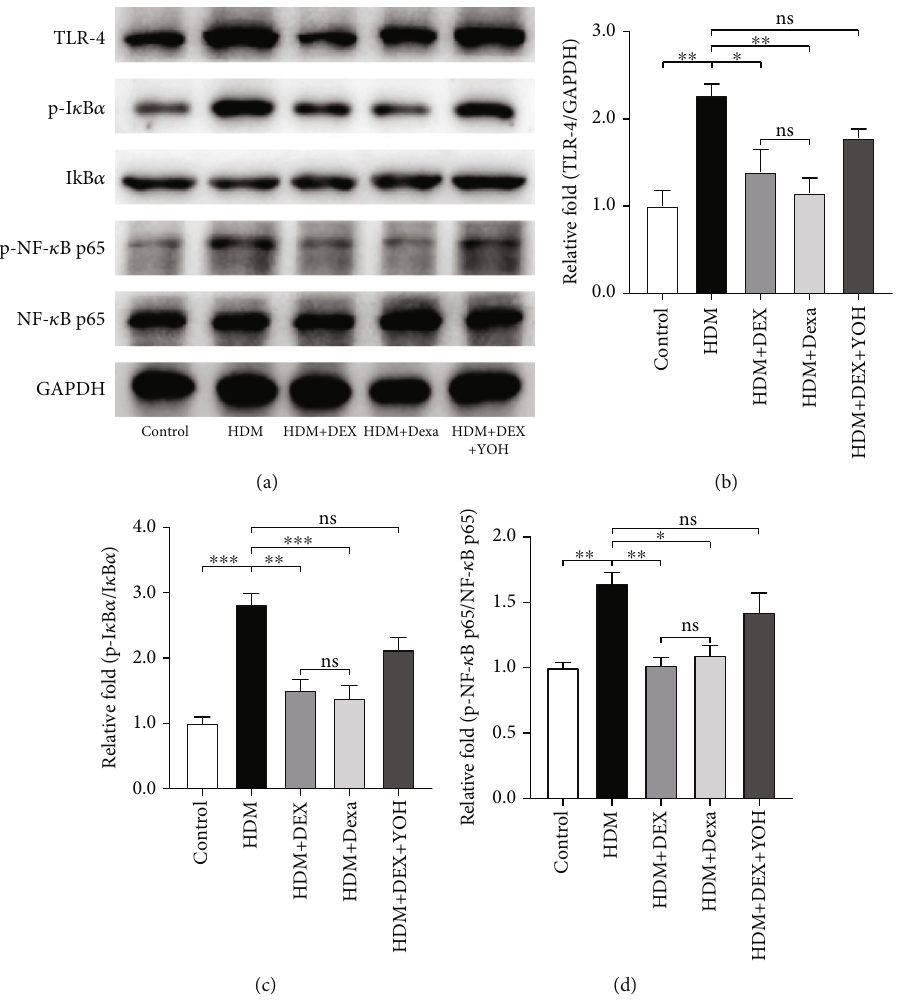
Figure 4: E ff ect of DEX on the expression levels of the TLR4/NF- κ B signaling pathway in lung tissues. (a) Representative images of western blots of TLR4, phosphorylated- (p-) I κ B α , I κ B α , p-NF- κ B p65, and NF- κ B p65. (b – d) Densitometric analyses of TLR4 and the ratios of p- I κ B α /I κ B α and p-NF- κ B p65/NF- κ B p65 in lung tissues form each group. Data were presented as mean ± SEM ( n = 3~ 5 animals). ∗ P < 0 : 05 , ∗∗ P < 0 : 01 , and ∗∗∗ P < 0 : 001